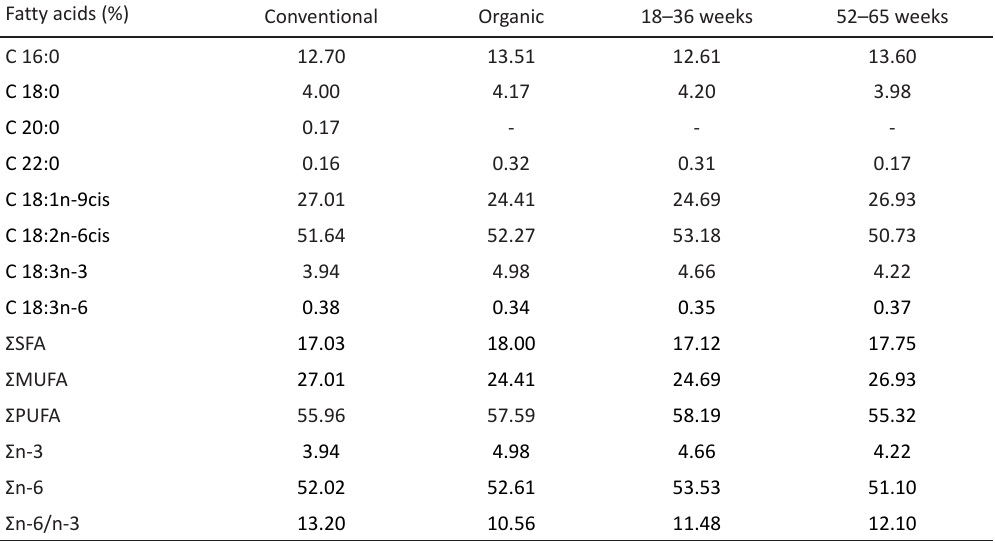
Table 2. Fatty acid composition of conventional and organic feeds in studied laying